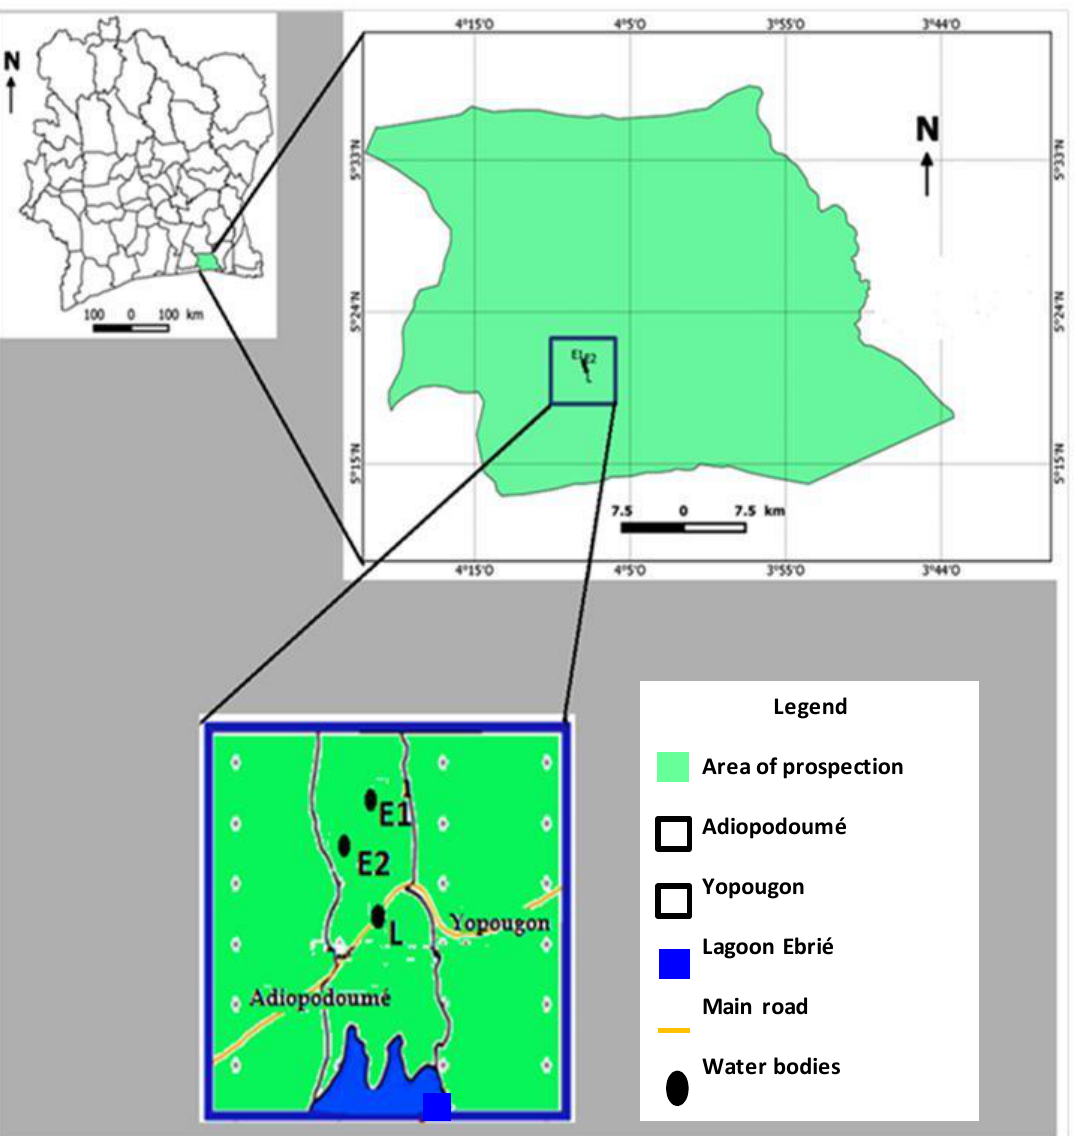
Figure 1. Study sampling site. Three water bodies were selected based on populations’ use and associated socio-cultural activities. L: Ebrié lagoon; E1: pond 1; E2: pond 2.